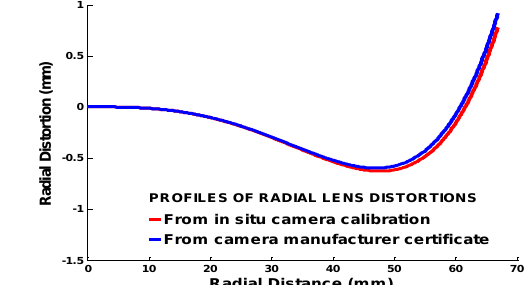
Figure 2. Profiles of radial lens